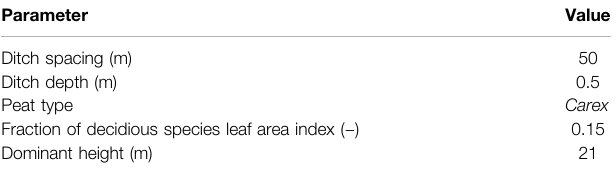
TABLE 2 | Parameter values applied in scenario